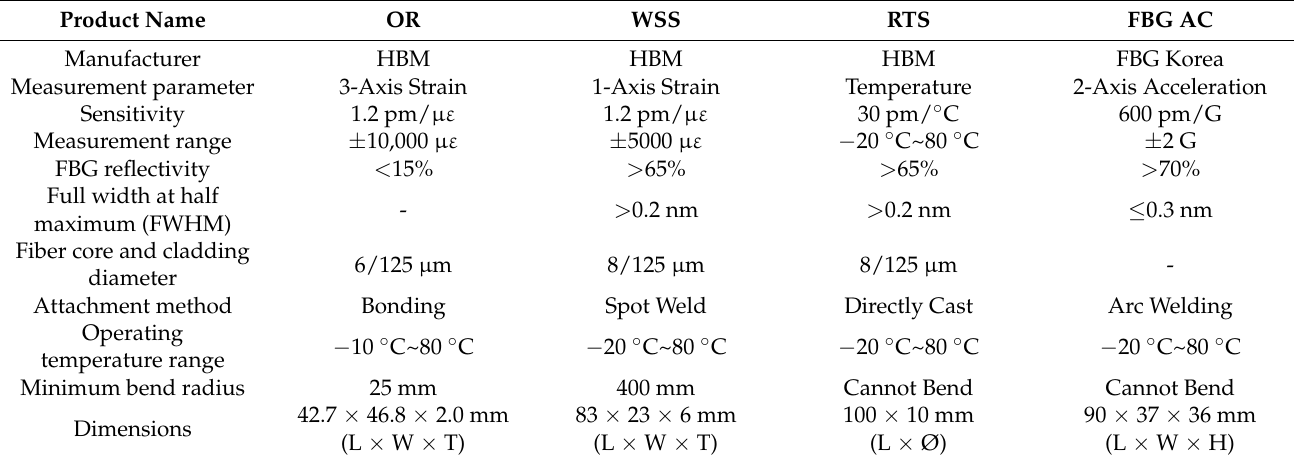
Table 1. FBG sensor